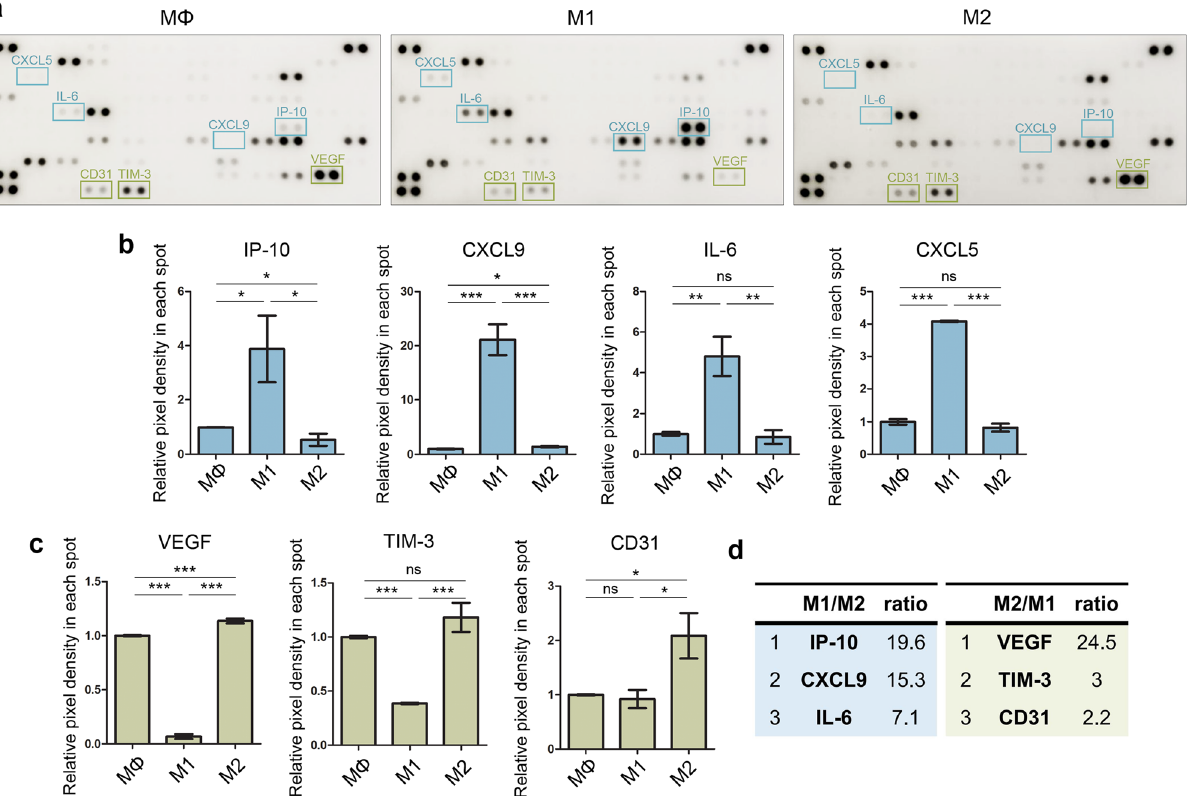
Figure 4. Confirmation of human cytokines in hiMel–macrophage coculture media. ( a ) Human cytokine array image of hiMel-macrophages (MΦ, M1, and M2) coculture media. Quantification of ( b ) proinflammatory markers and ( c ) proangiogenic markers. Data are expressed as the mean ± SEM. * p < 0.05, ** p < 0.01, *** p < 0.001 indicate statistical significance. ( d ) Cytokines were ranked by M1/M2, M2/M1 ratio. ns non-significant, MΦ